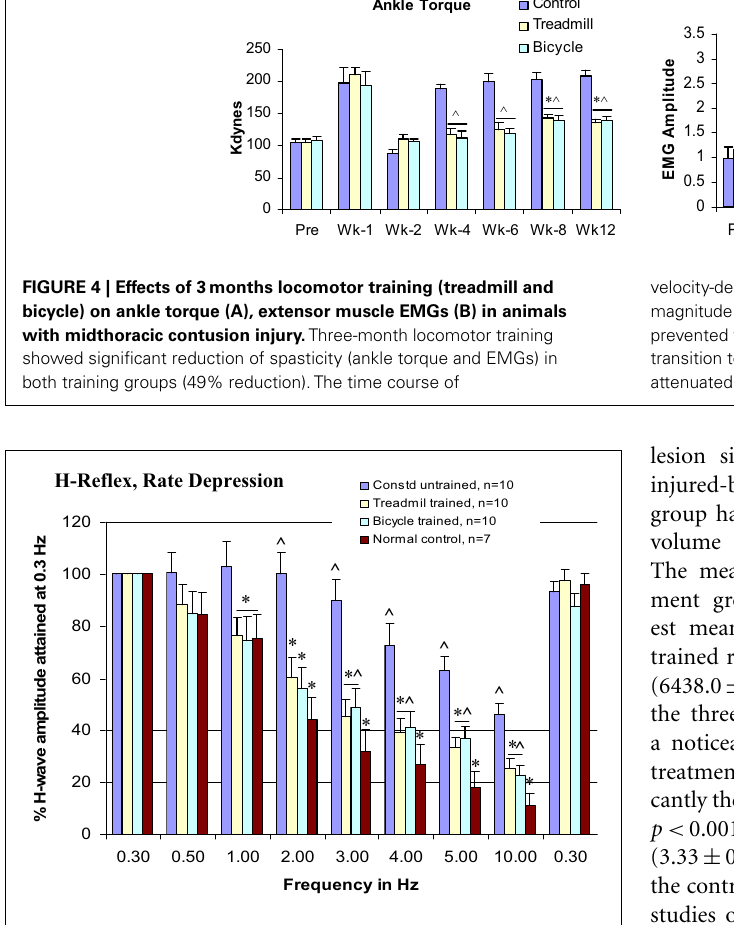
FIGURE 5 | Both types of locomotor training enhance rate-depression of H-reflex at 1–10Hz test frequencies,ANOVA, * p < 0.05, compared with contused untrained controls, and ∧ p < 0.05, compared with normal intact animals.